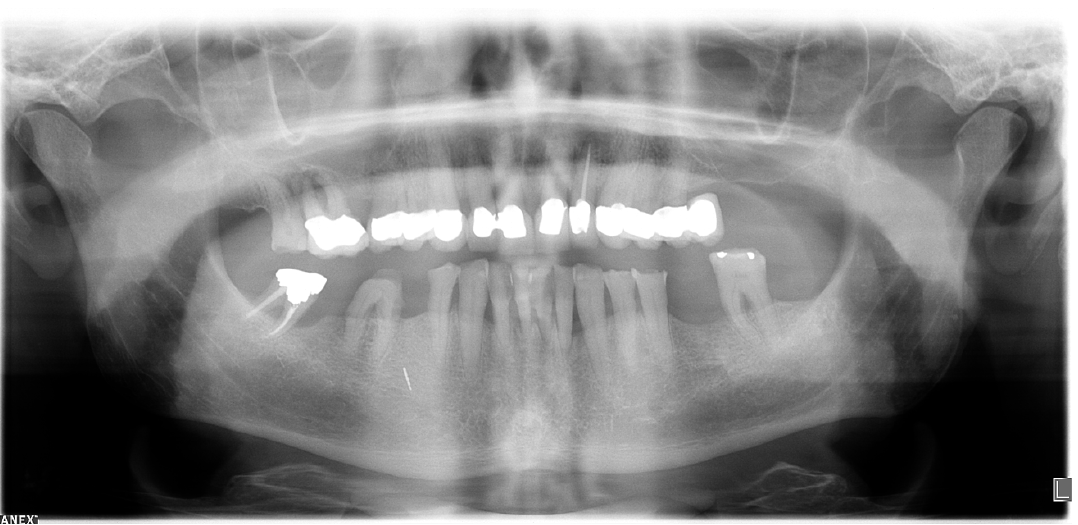
Figure 3. Periapical X-ray with the broken periodontal probe.3. Diagnosis. Based on the X-ray findings and visible markings on the metal object, we surmised that this was a broken periodontal probe tip. It appeared to be either a PCPUNC-15 or AE P OWP, both of which are similar, although the latter is shorter and does not have a 4 mm marking (Figure 4). The definitive identification could only be made after removal when we were able to measure and assign the fragment tip accordingly (Figures 5 and 6). Details and photographs of the patient’s oral status can be found in the Supplementary file.